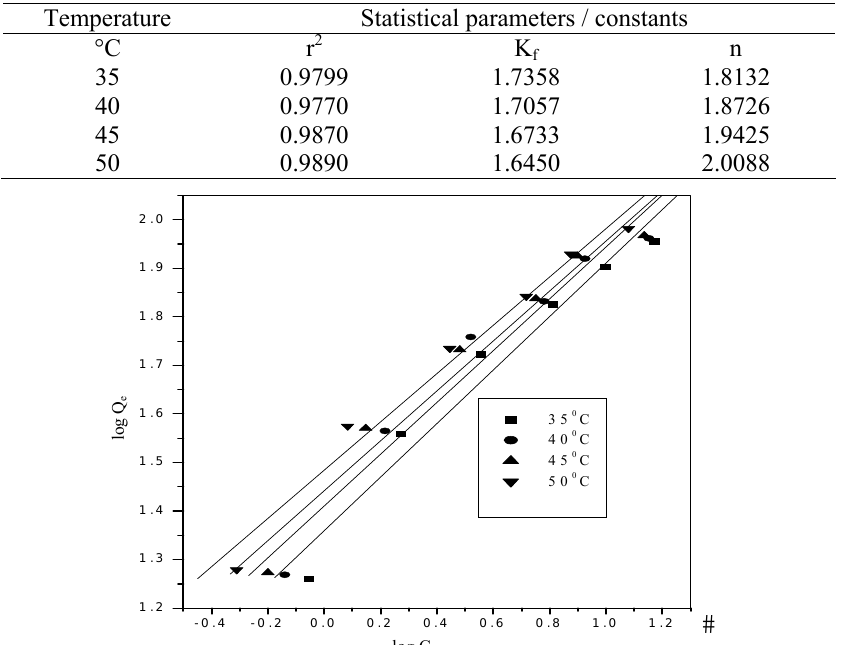
Table 5. Freundlich isotherm results for the adsorption of copper ion by CBC